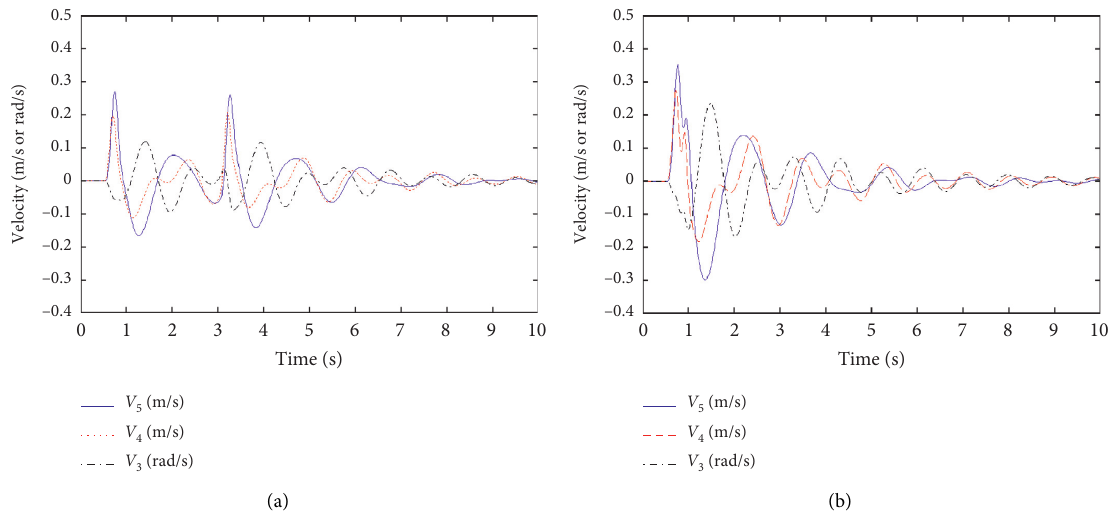
Figure 5: Responses of displacement U displacements of the driver U 5 , the chassis U 4 , and the pitch angle U 3 , i.e., U seconds, sampling interval h � 0.01seconds, vehicle velocity v � 1.1256m/s (the time delay τ � 2 . 5s) and (b) same as (a) except for the vehicle velocity v � 20m/s (the time delay τ � 0 . 0938 s).